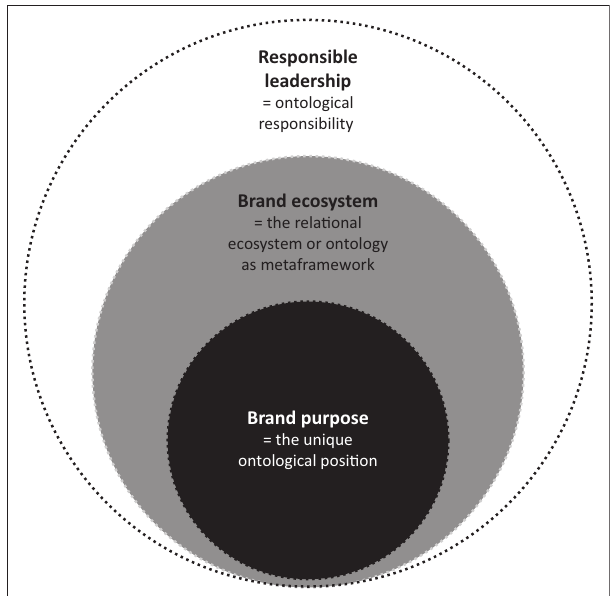
FIGURE 3: Brand purpose and responsible leadership as an interrelated